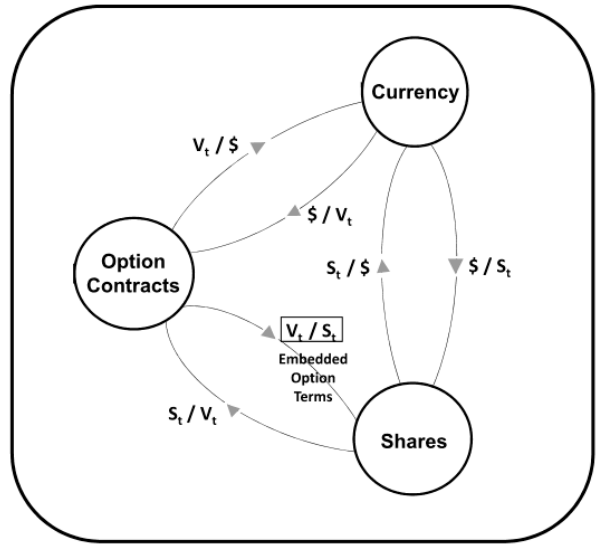
Figure 1. Generalized market connections between assets and implicit exchange rates. $: 1 USD.